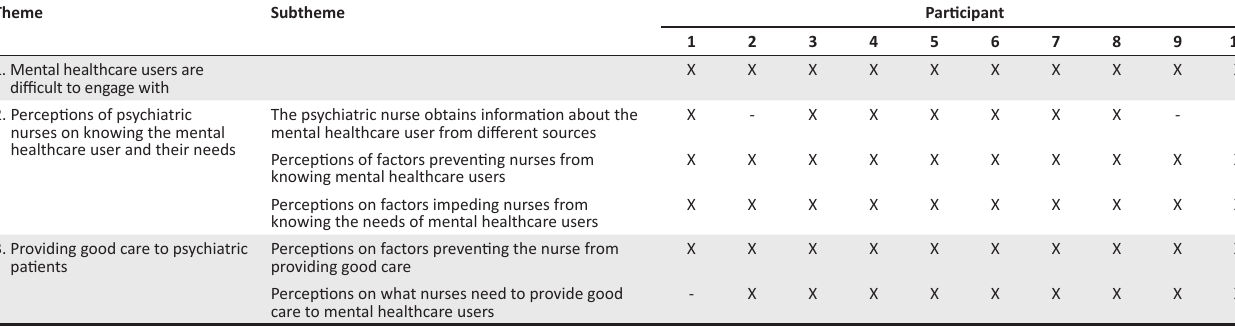
TABLE 4: Themes and subthemes with an indication of data saturation. Theme